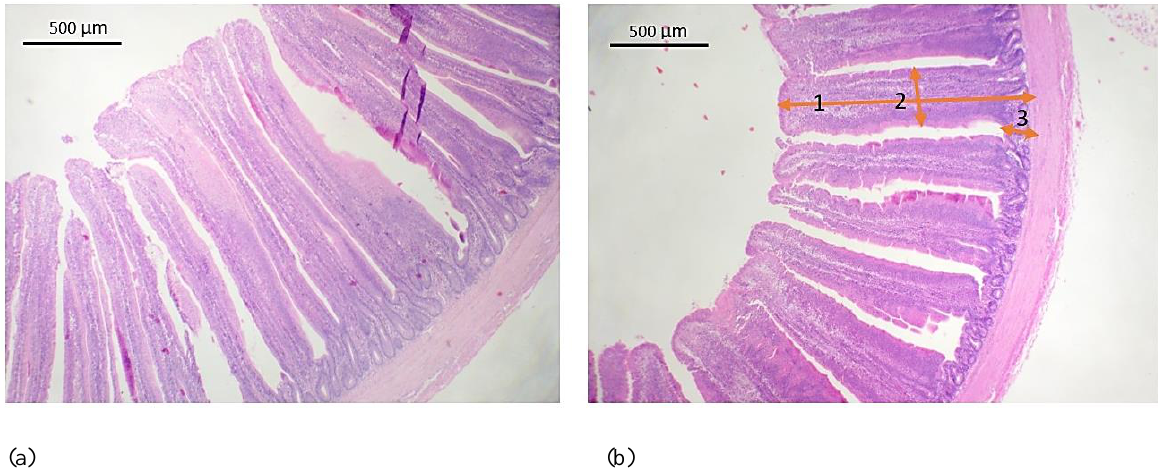
Figure 1. Small intestinal epithelium morphometrics: ( a ) green-legged partridge and ( b ) Sasso. The numbers indicate the morphometric measurements taken: 1—the villus height; 2—the villus width; 3—the crypt depth. Calculations using villus height and width at half height gave the villus surface area, H-E, scale bar 500 μm.